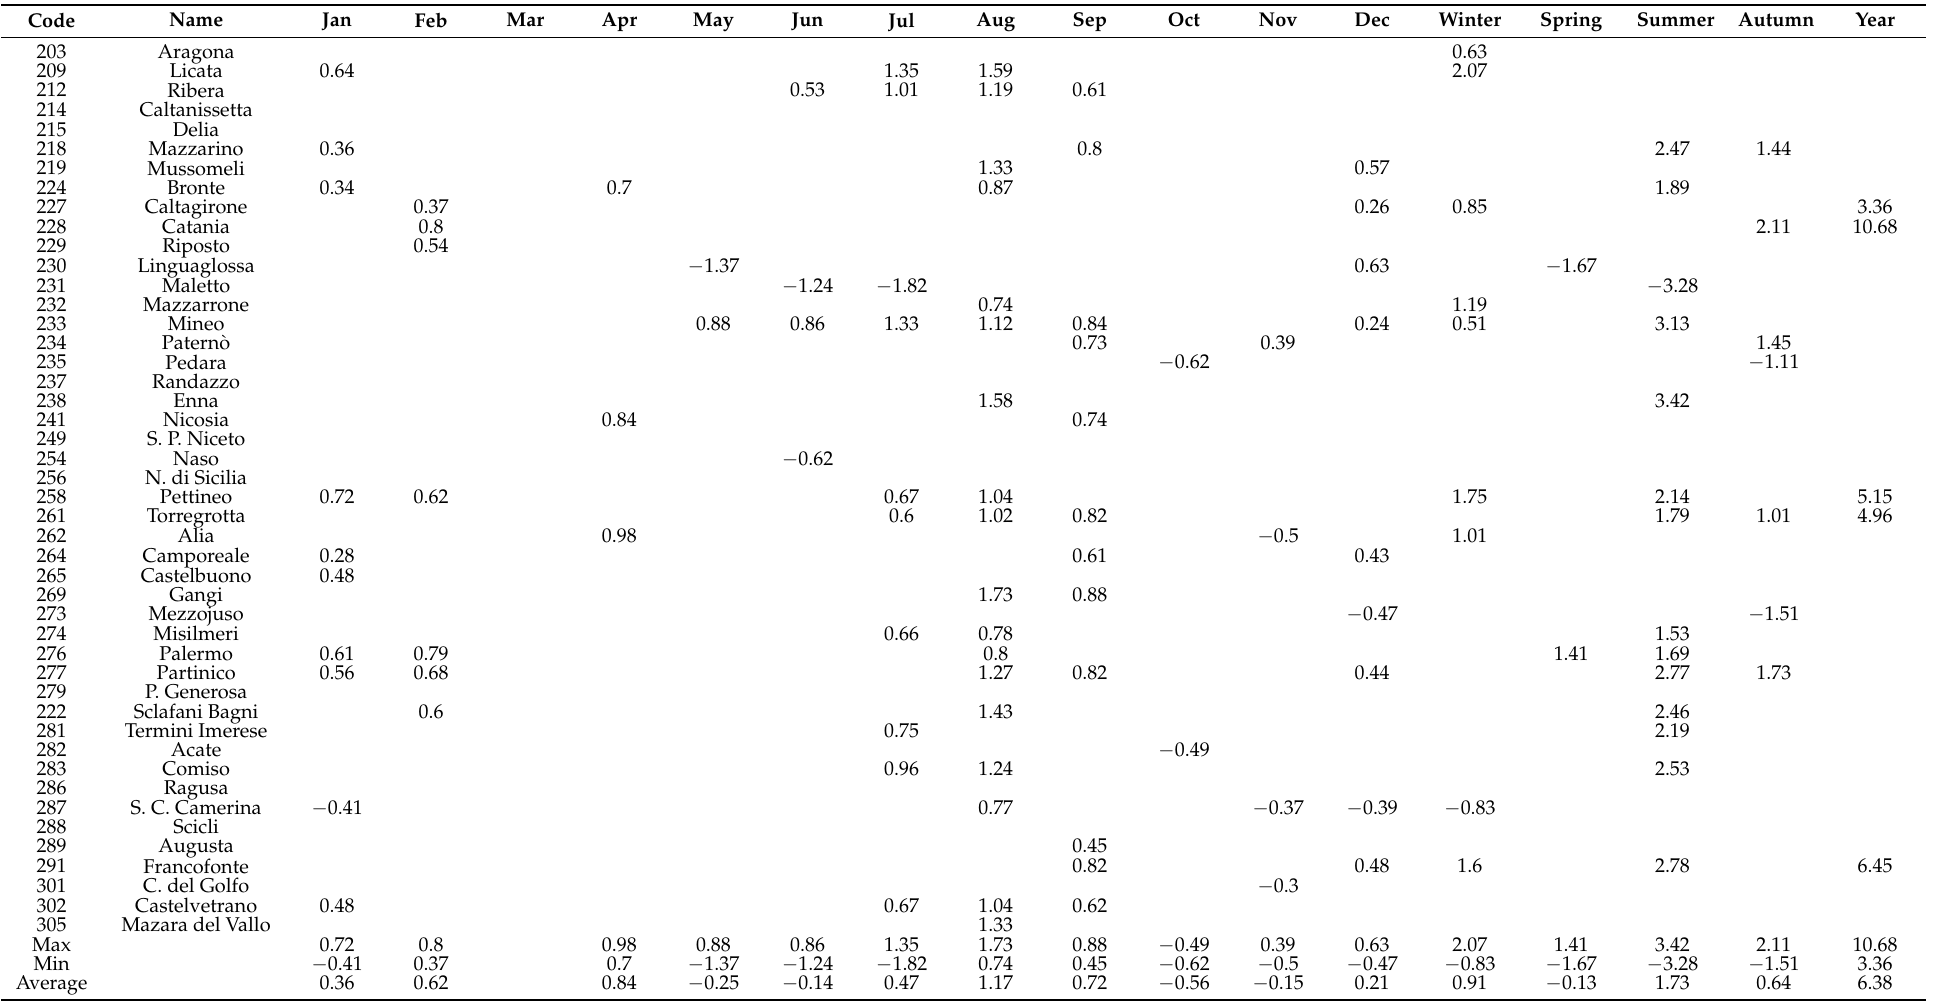
Table 3. Sen’s slope result in